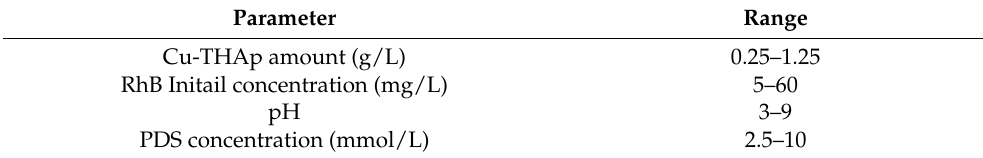
Table 1. Parameters and their related ranges to find optimal operational